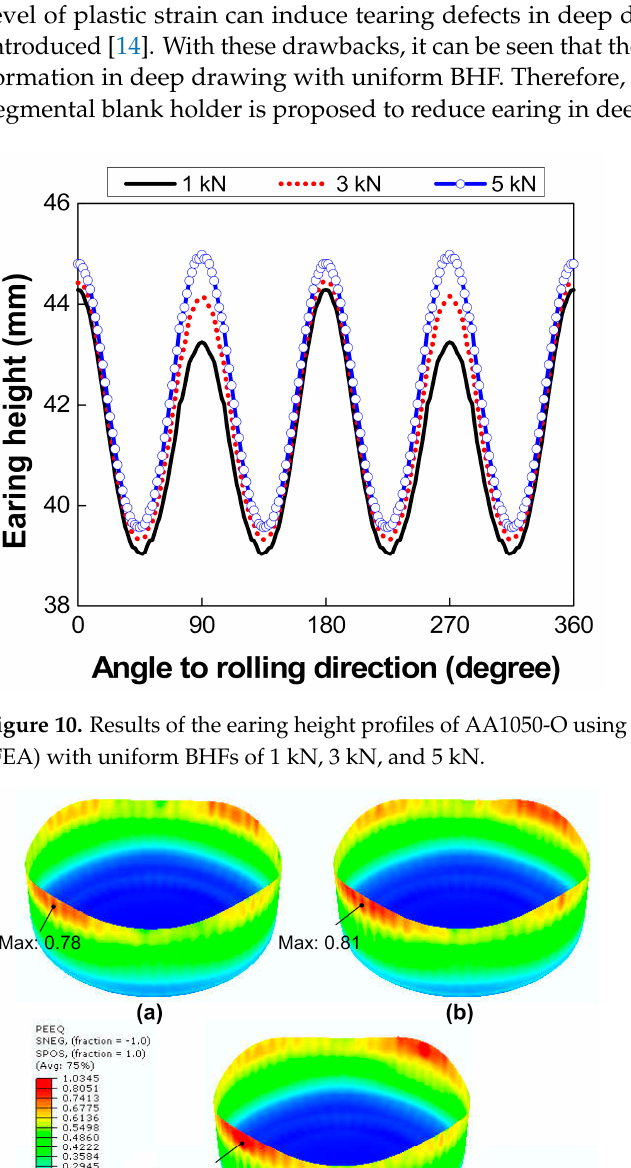
Figure 11. Equivalent plastic strain distribution of the deep-drawn cup of AA1050-O using uniform BHFs of ( a ) 1 kN, ( b ) 3 kN, and ( c ) 5 kN.